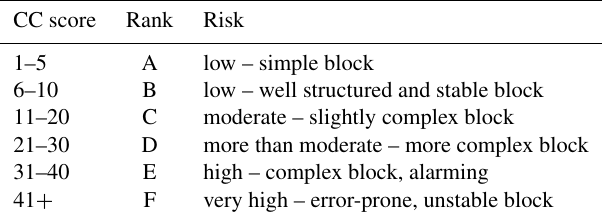
Table 20. Ranks of cyclomatic complexity (CC) taken from the manual of the Python package radon (Lacchia,